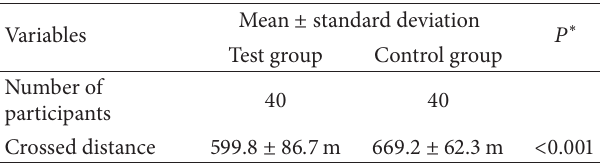
Table2:Presentationofthegroupsstudiedinrelationtothemileage meter.